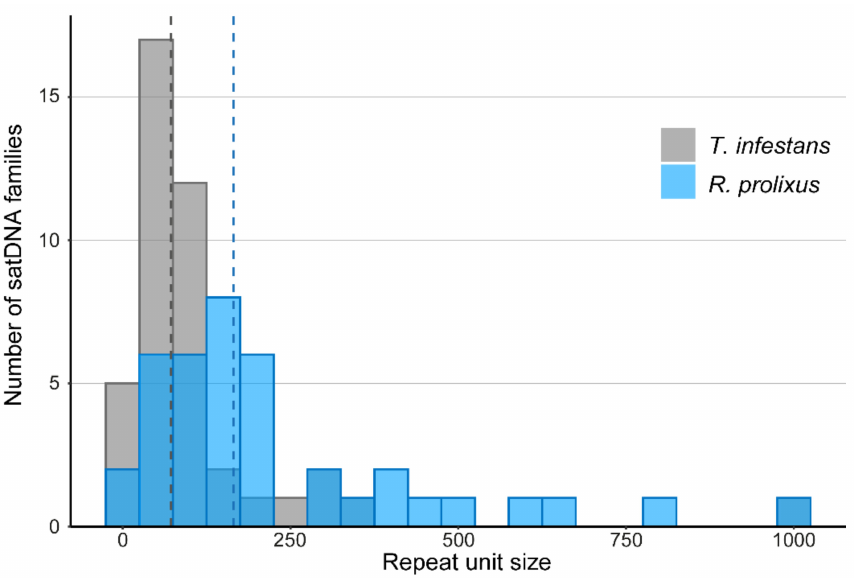
Figure 1. Repeat unit size distribution on Rhodnius prolixus and Triatoma infestans . Dashed lines represent median value of repeat unit size for R. prolixus (163 bp) and T. infestans (72